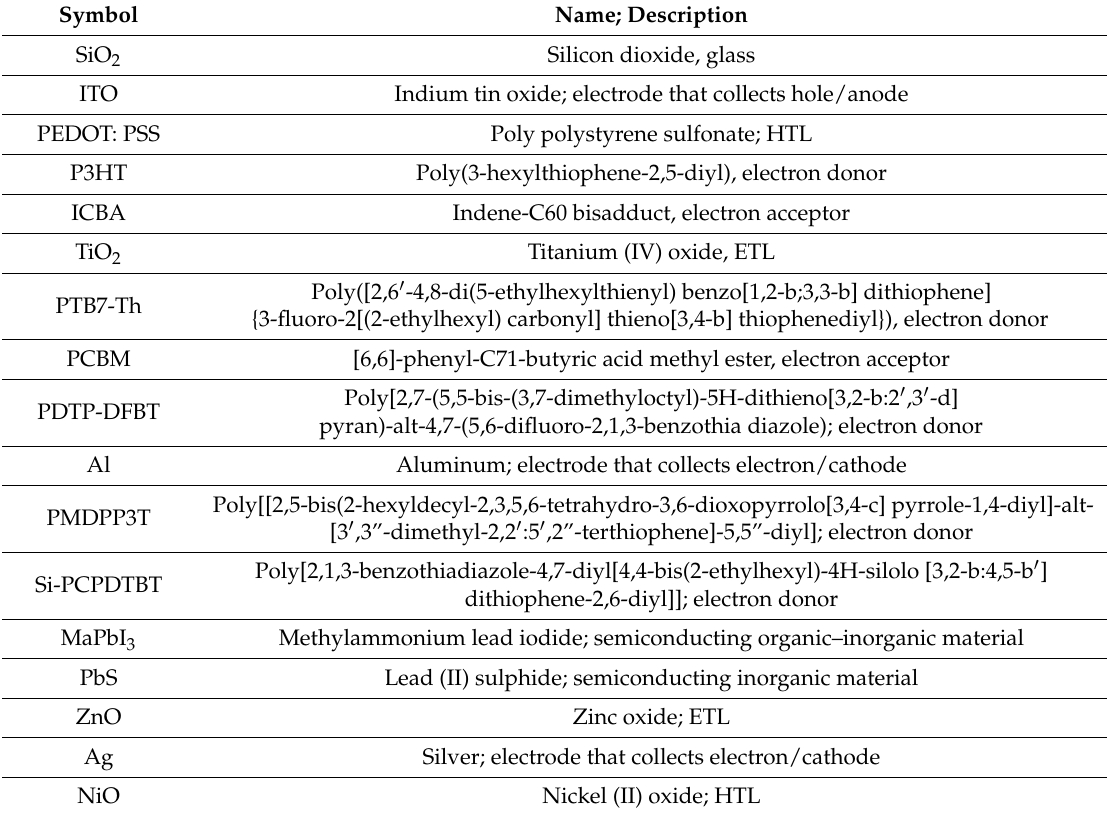
Table 1. Description of organic and inorganic materials used in the simulation